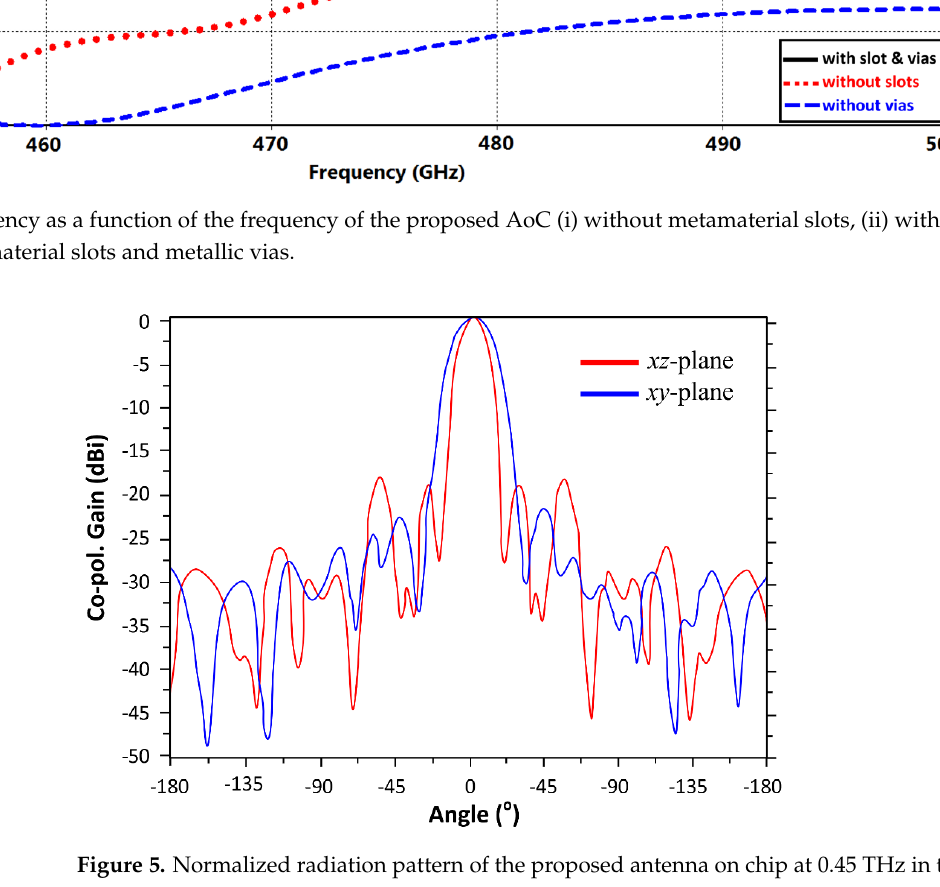
Figure 4. Radiation efficiency as a function of the frequency of the proposed AoC (i) without metamaterial slots, (ii) without metallic vias, and (iii) with metamaterial slots and metallic vias.